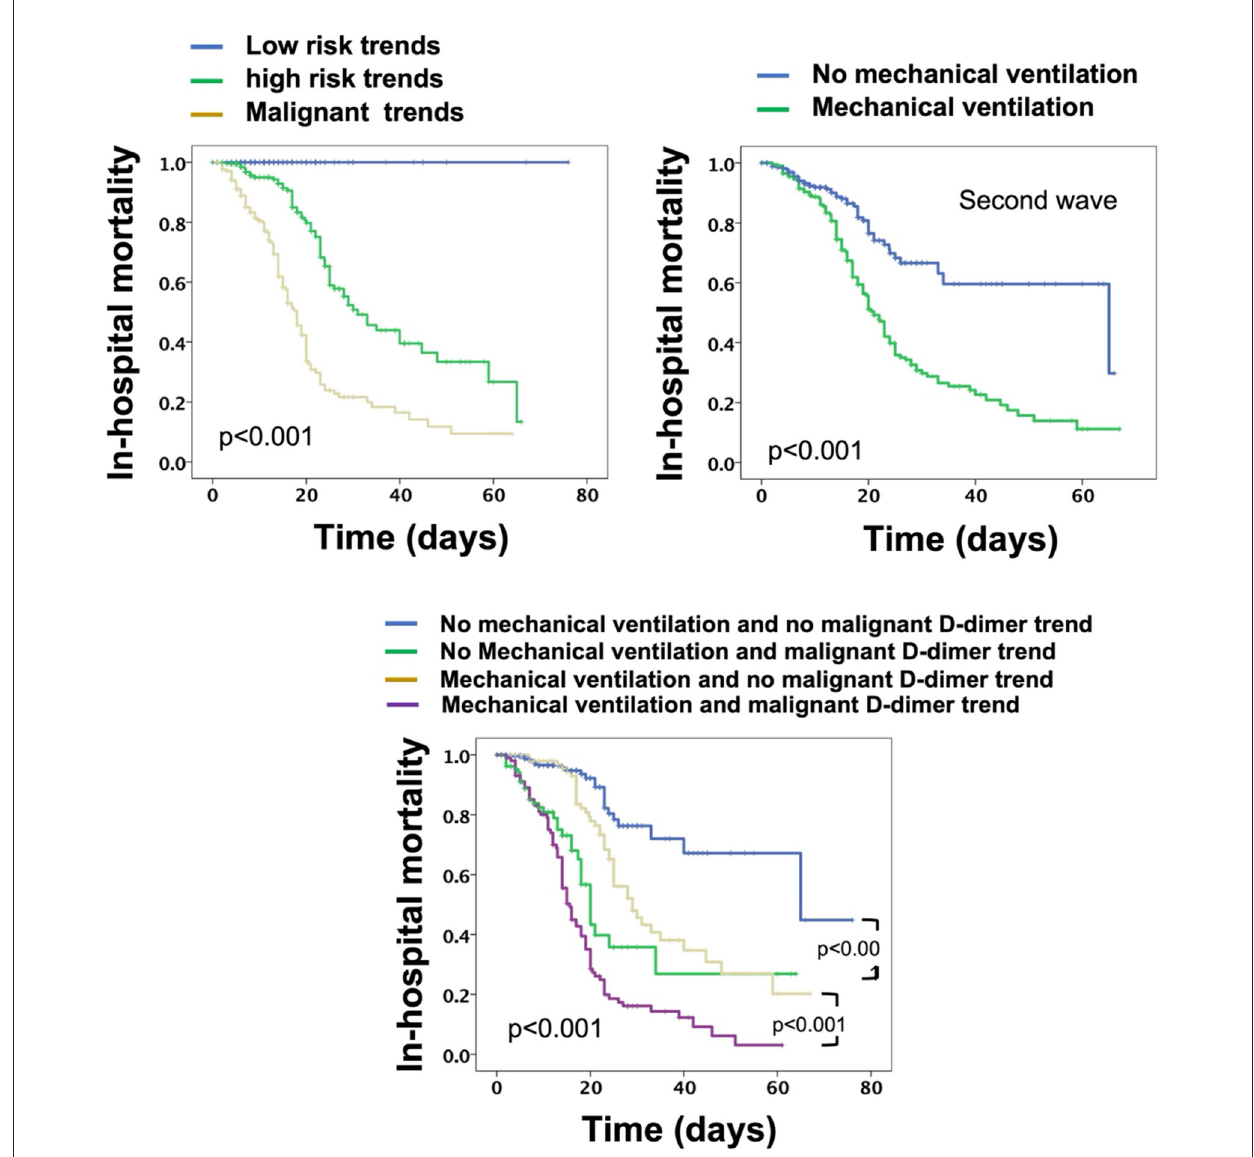
FIGURE4 Kaplan–Meier curves for overall in-hospital mortality for patients stratified based on D-dimer trends, mechanical ventilation, and